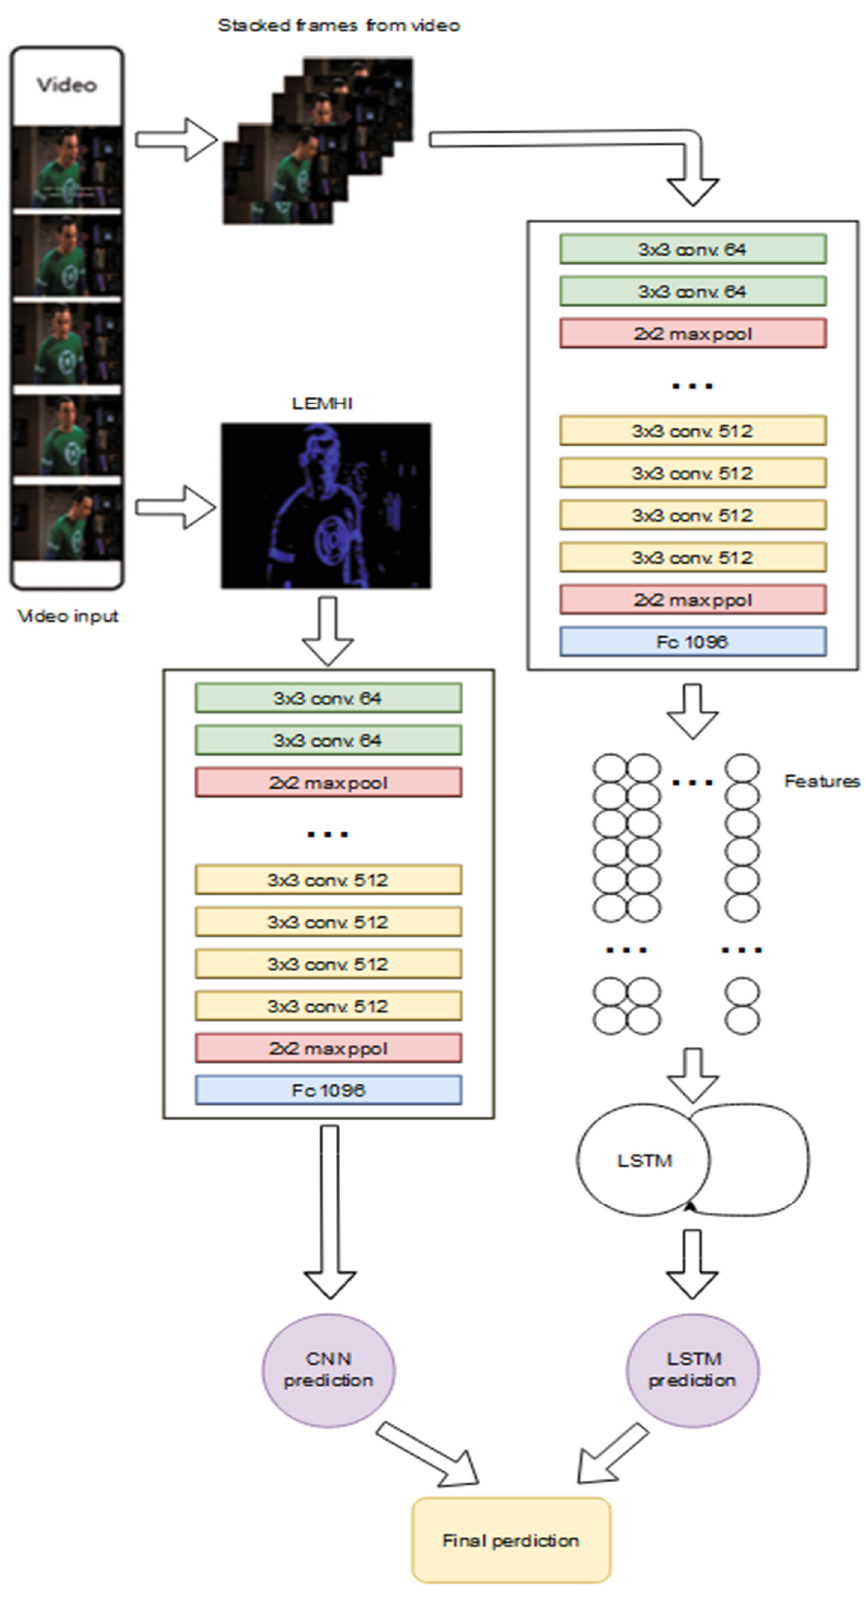
Figure 7. Proposed model for motion history image.